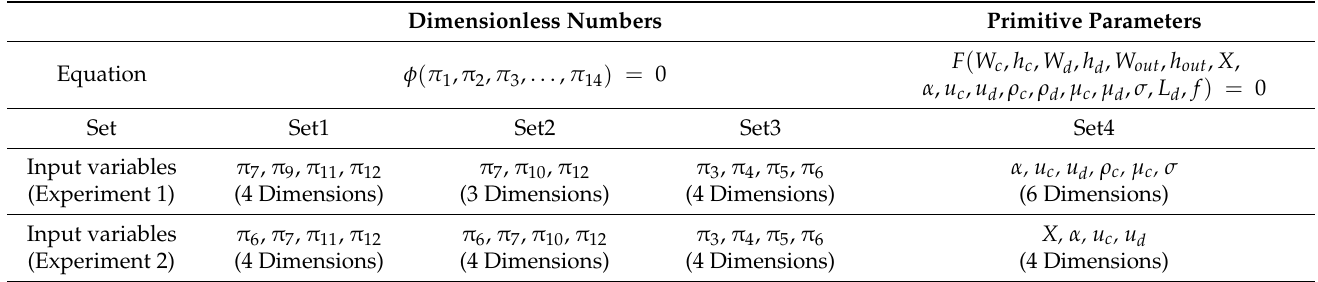
Table 3. Input variables using dimensionless numbers and primitive parameters in the ML model.